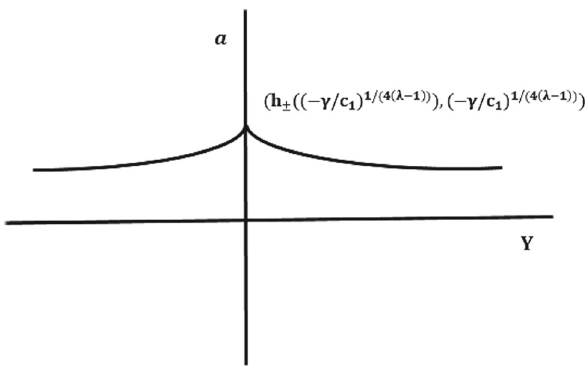
Fig. 6 Graph of the warp factor as a function of Y , for ( n + 1 )/ n < λ < ( n − 1 )/( n − 2